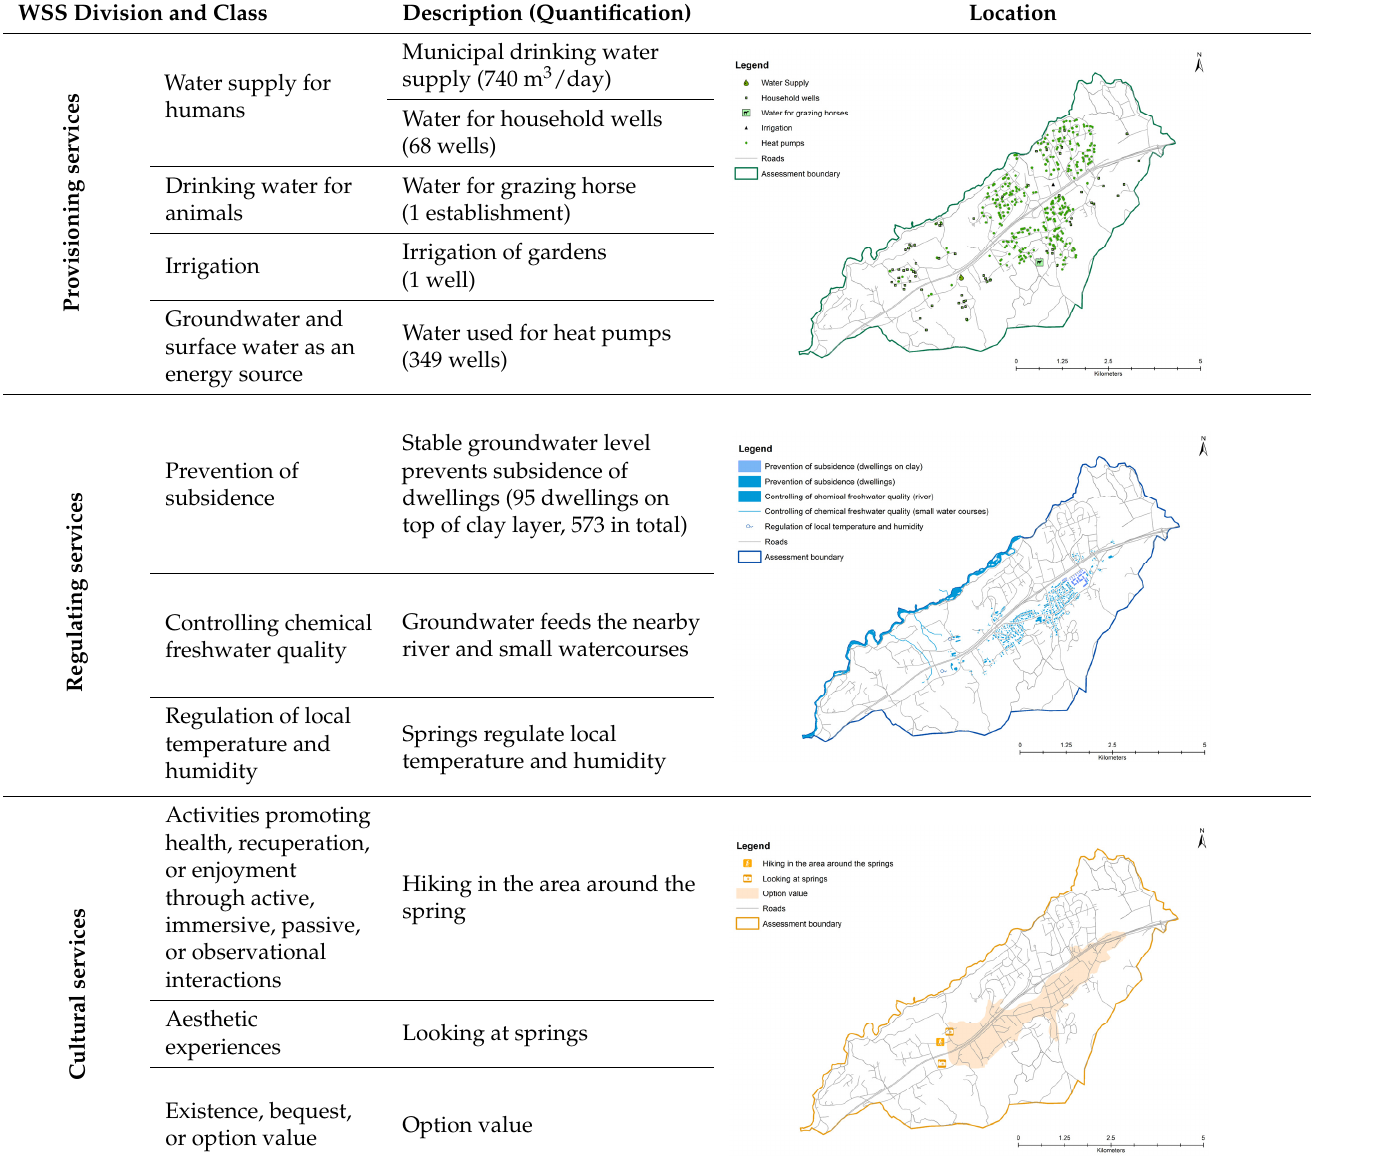
Figure 6. Identified hazard sources that pose a risk to the municipal drinking water supply. 4.2.3. Risk